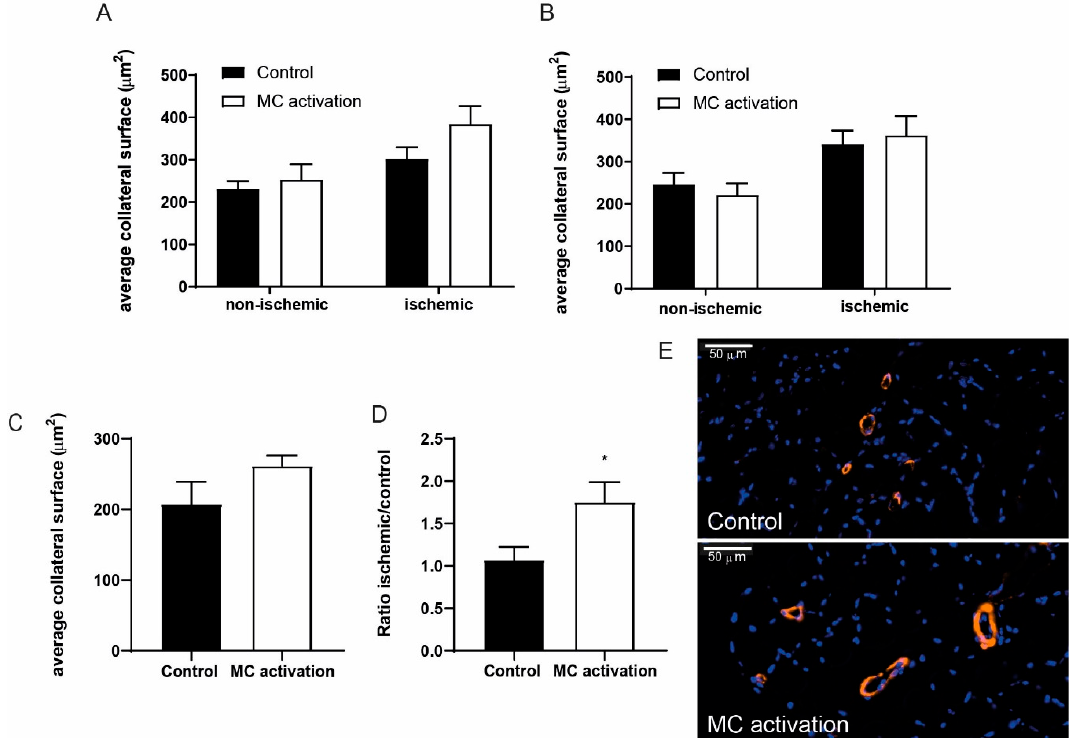
Figure 5. Arteriogenesis upon mast cell activation in the ischemic hind limb. The average collateral surface area in ischemic as compared to non-ischemic adductor muscles of mice in which mast cells were activated compared to controls at ( A ) 28 days after ligation and ( B ) 9 days after ligation. ( C ) The average collateral surface area in the soleus muscle of mice in which mast cells were activated compared to controls. ( D ) The collateral area ratio between ischemic and non-ischemic soleus muscles in mast cell activated compared to control mice at nine days after femoral artery ligation. ( E ). Representative pictures of smooth muscle cell actin positive collaterals in orange and nuclei in blue (DAPI) in both a control muscle and a muscle in which mast cells were activated. * p <